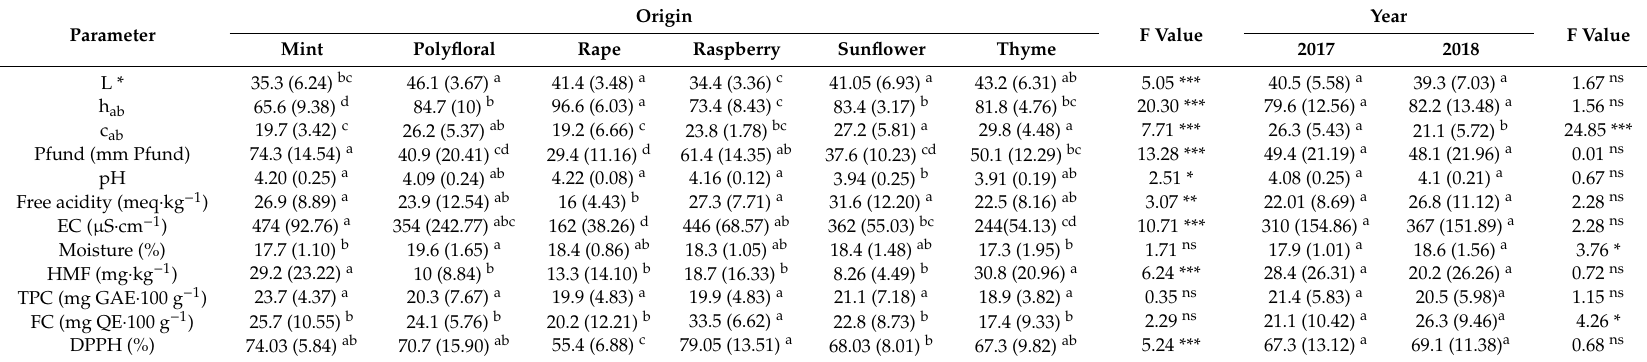
Table 2. Physicochemical properties for di ff erent types of honey (raspberry, mint, rape, thyme, polyfloral and sunflower). Mean values and standard deviation in